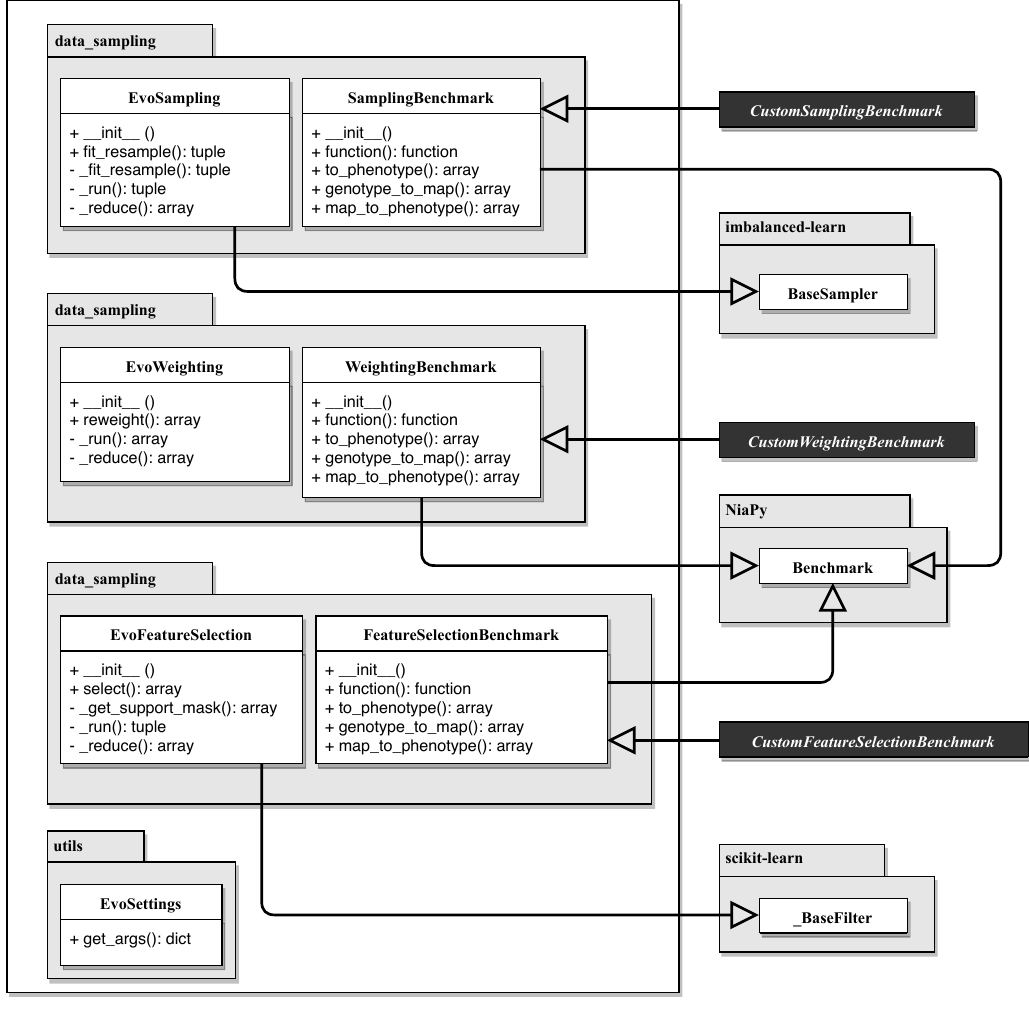
Figure 5. UML class diagram of the EvoPreprocess